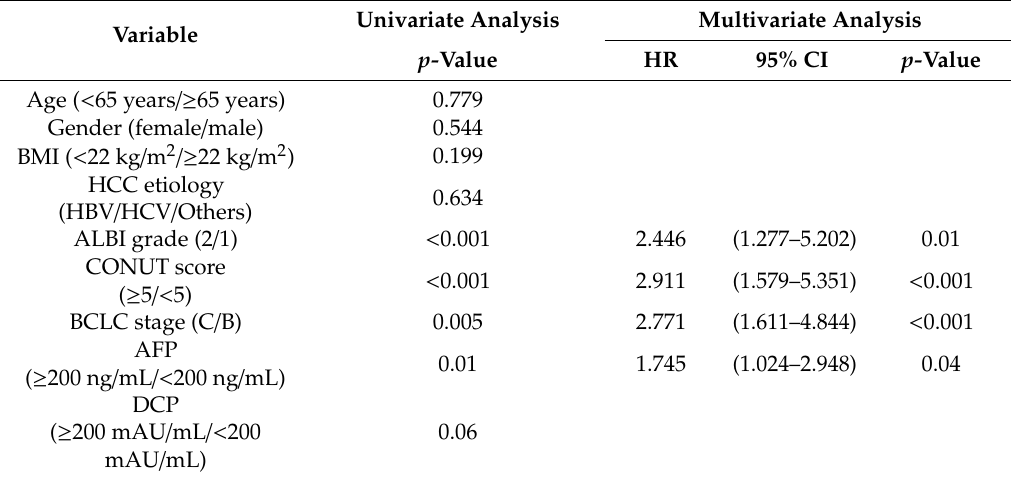
Table 3. Univariate and multivariate analyses of factors potentially associated with